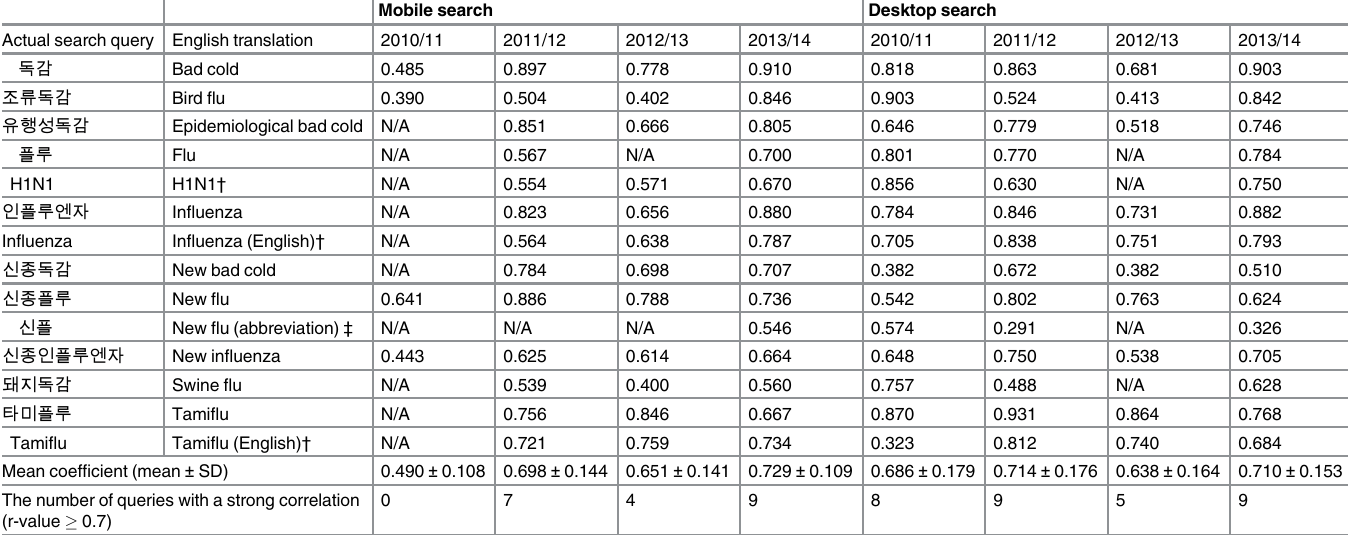
Table 1. Correlation coefficients between KCDC ILI data and mobile and desktop device search query data from epidemiological years 2010/11 through to 2013/14. Mobile search Desktop